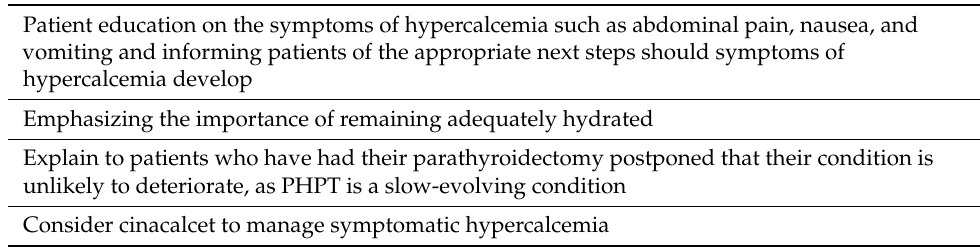
Table 2. A summary of the key priorities for managing primary hyperparathyroidism (PHPT) during the COVID-19 pandemic